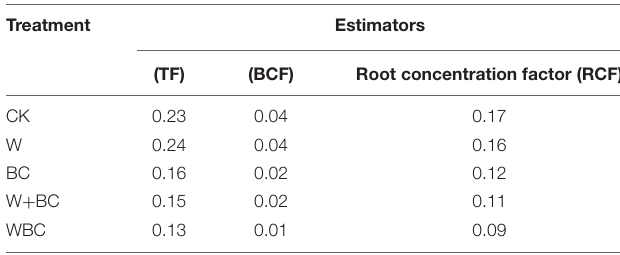
TABLE 2 | Effect of Ryegrass on Cr enrichment coefficient and transfer coefficient under the action of biochar-based Cr-reducing bacteria.